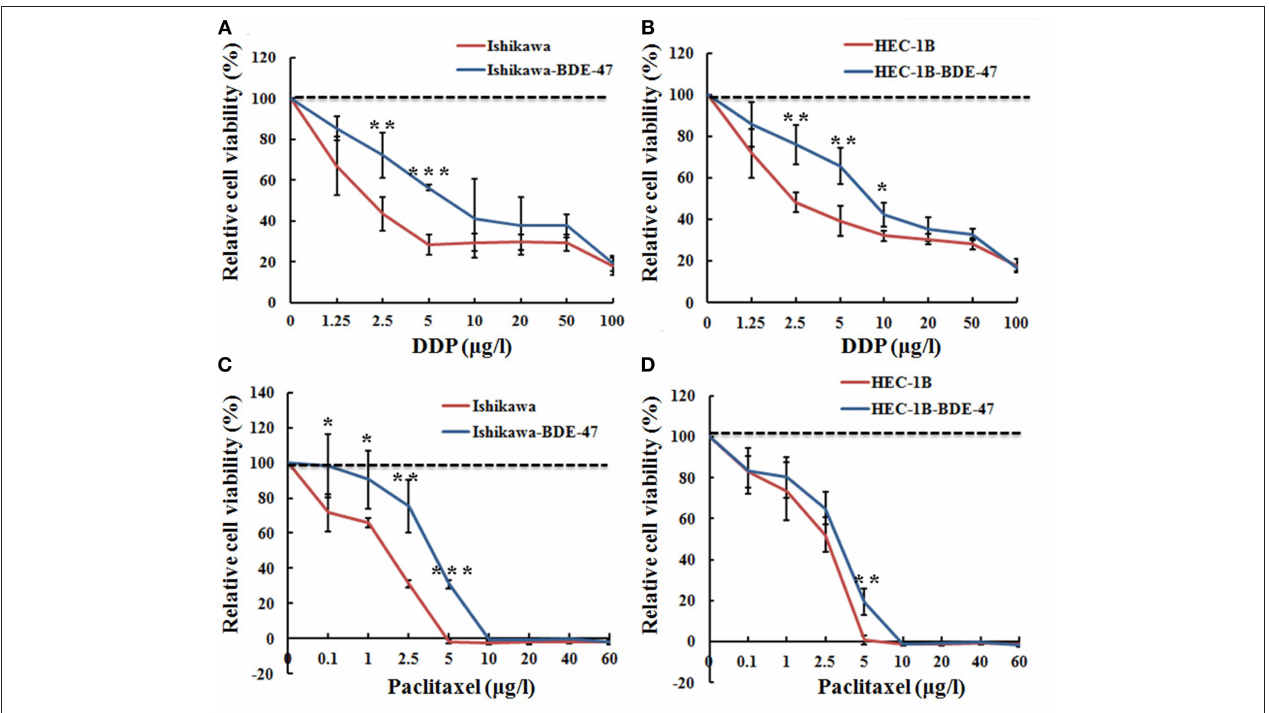
FIGURE 2 | Relative cell viability of Ishikawa-BDE-47, HEC-1B-BDE-47 and their parental cells before and after treatment with DDP or paclitaxel. MTT assays were performed before and after retreatment with different concentrations of DDP for 48h in Ishikawa-BDE-47 (A) , or in HEC-1B-BDE-47 cells (B) , as well as their parental cells. Different concentrations of paclitaxel were also used to treat Ishikawa and Ishikawa-BDE-47 (C) , as well as HEC-1B and HEC-1B-BDE-47 (D) , and then after 48h, relative cell viability was assessed. * P < 0.05; ** P < 0.01; *** P < 0.001.